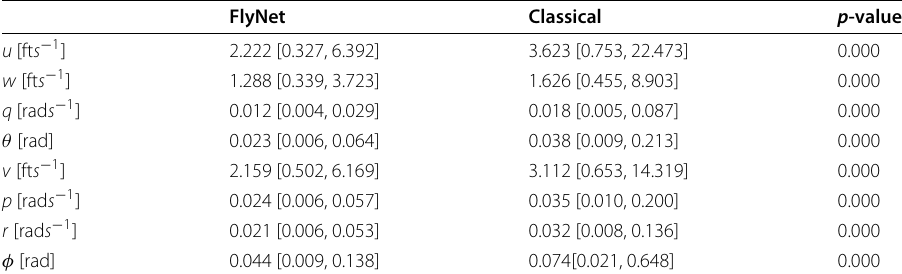
Table2 Average RMSEs in test set ( N = 45) for each channel with 95% CI and p -value FlyNet Classical p -value u [ft s − 1 ] 2.038 [0.468, 6.082] 3.171 [0.780,